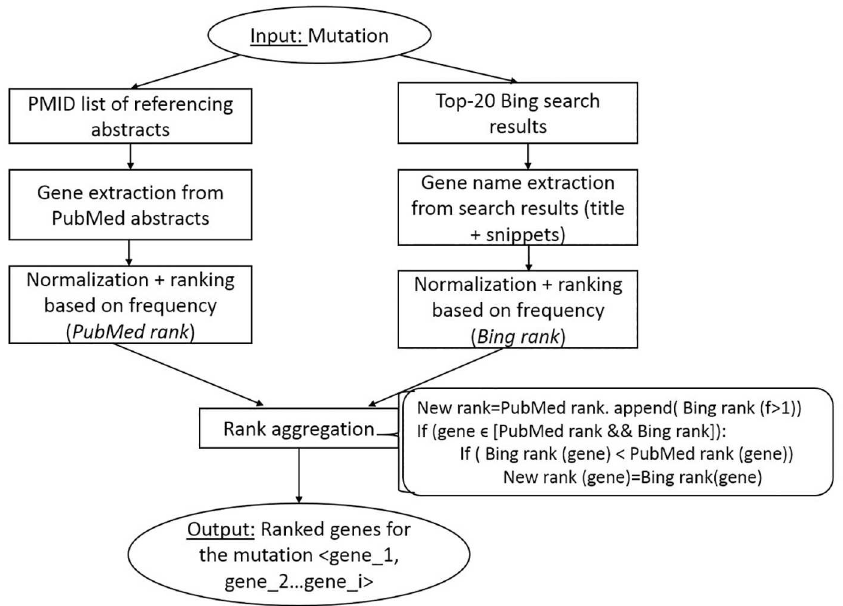
Fig 3. A schematic of identifying a ranked list of genes using global knowledge for a given